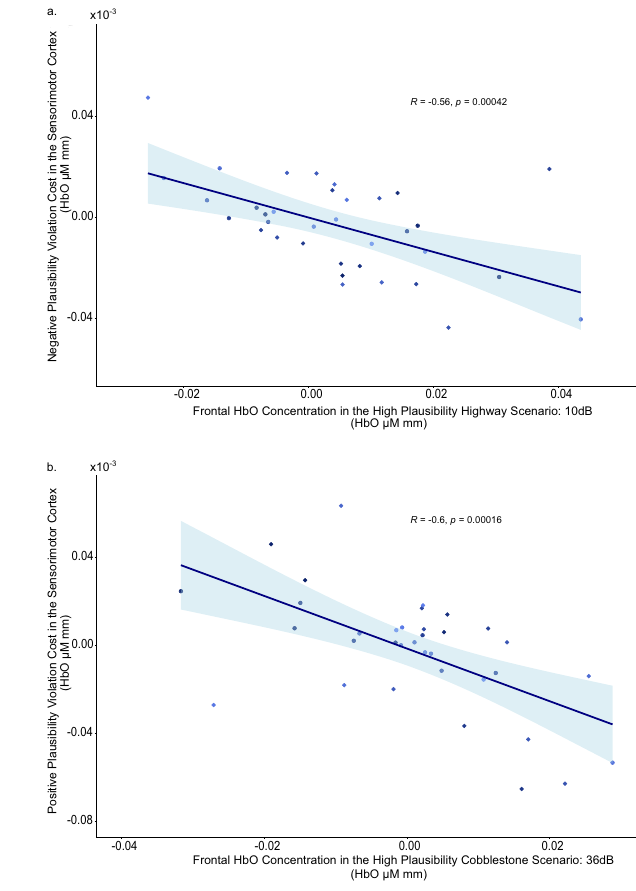
Fig. 5 Scatterplots showing negative correlations between plausibility violation costs in the somatosensory cortex and HbO concentration in the frontal regions. a Results regarding the scenario of high plausibility with 10 dB vibrotactile stimulation ( n = 35 young adults). b Results regarding the scenario of high plausibility with 36 dB vibrotactile stimulation. Shaded area represents the 95% con fi dence interval ( n = 35 young